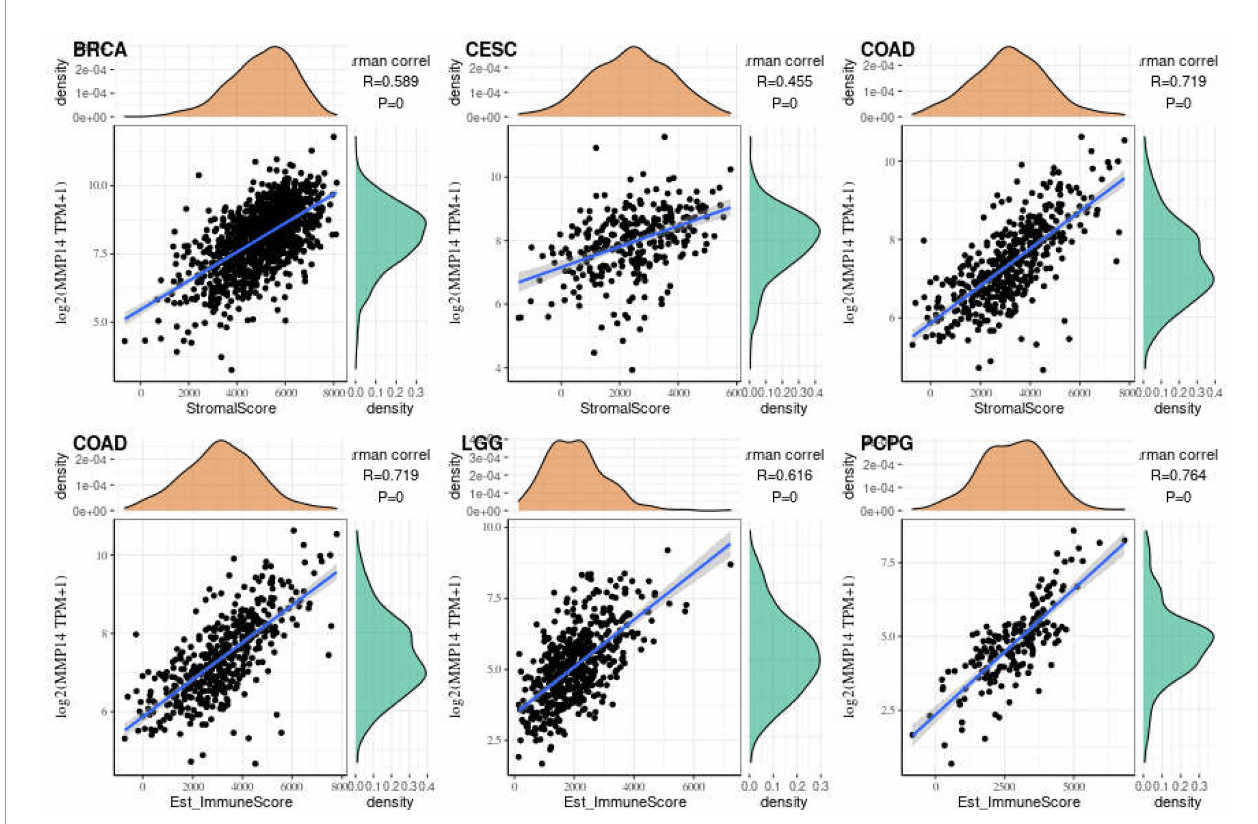
FIGURE 9 | The three tumors with the highest correlation between matrix metalloproteinase 14 (MMP14) expression and immune score and stromal score in the pan-cancer analysis. The expression of MMP14 is positively correlated with the in fi ltration levels of these immune